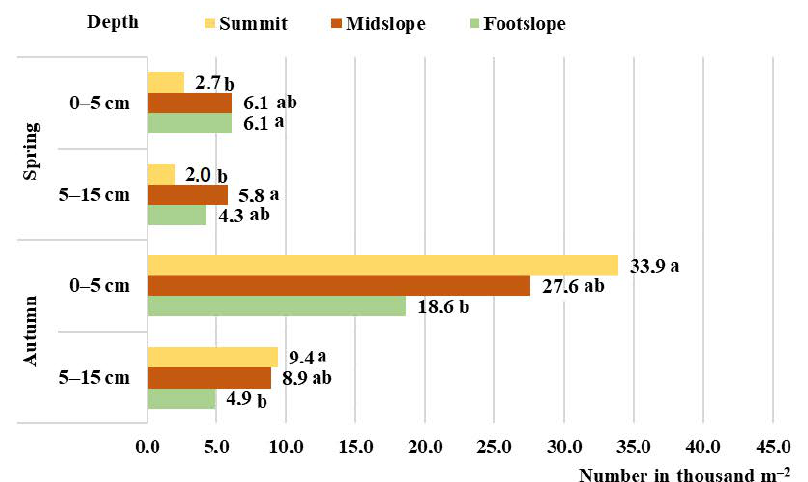
Figure 1. The number of seeds in a pre-erosion cereal-grass crop rotation soil in 2020. Letters “a” and “b” indicate significant ( p < 0.05) differences between the means.